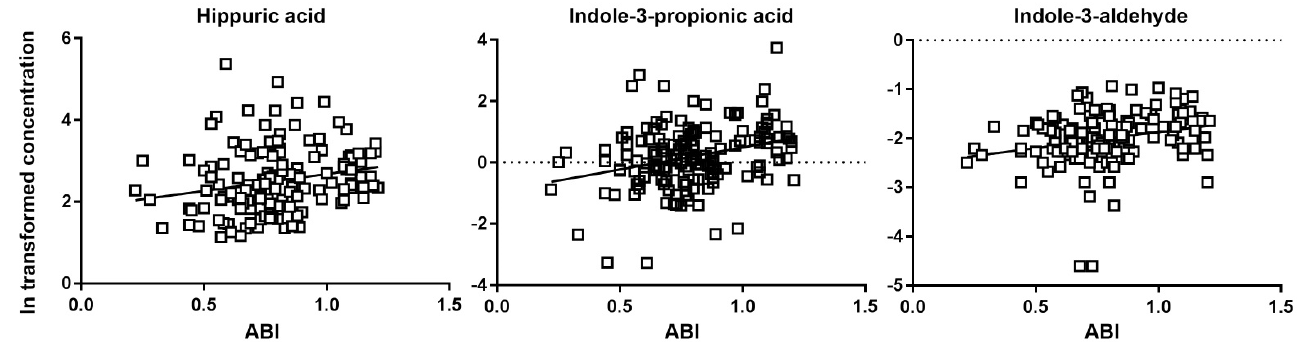
Figure 1. Correlations between ln-transformed metabolite concentrations and ankle-brachial index (ABI). Only correlations with p < 0.05 are shown. Each line represents the linear regression of each metabolite on ABI. Spearman coefficients and p values are provided in the text.